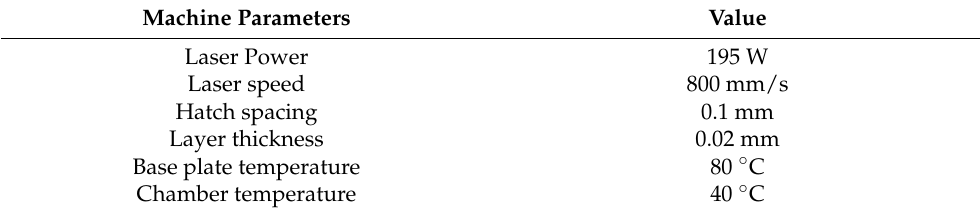
Table 1. Machine